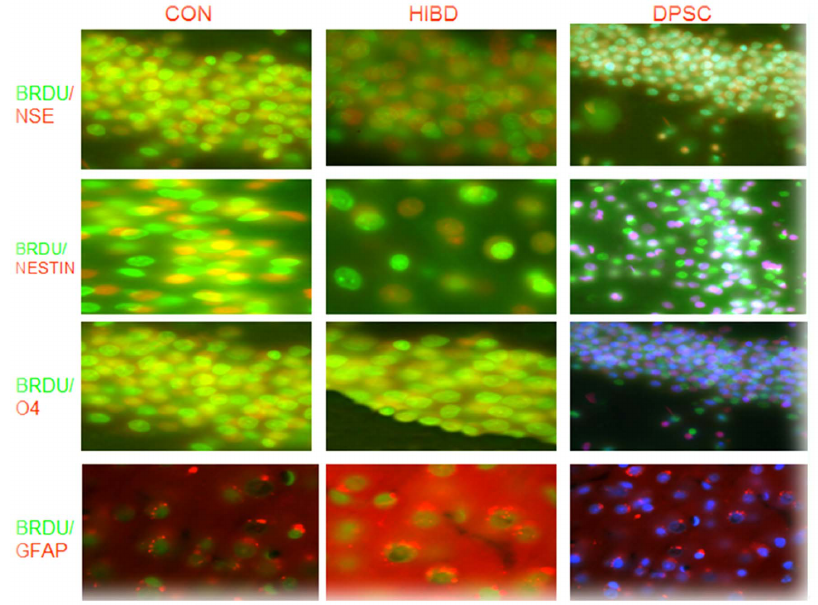
Figure 2. In vivo DPSC differentiation at 37 days after intraventricular injection (300 6 ). The subventricular zone is shown. BrdU: bromodeoxyuridine; CON: control; DPSC: dental pulp stem cells; GFAP: glial fibrillary acidic protein; HIBD: hypoxic-ischemic brain damage; NSE: neuron-specific enolase; O4: oligodendrocyte marker O4.